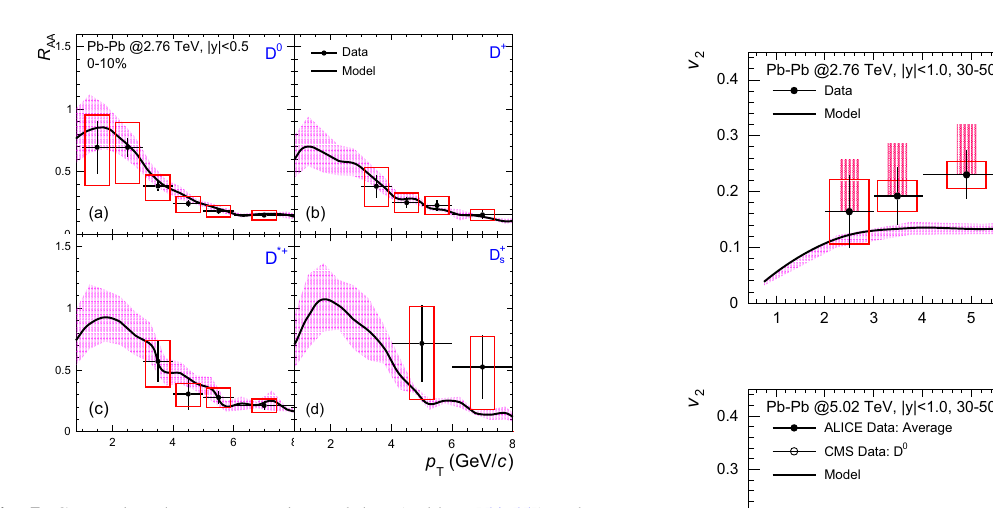
Fig. 8 Same as Fig. 7 but for Pb–Pb collisions at The data (solid [56], open [70]) are shown for comparison.